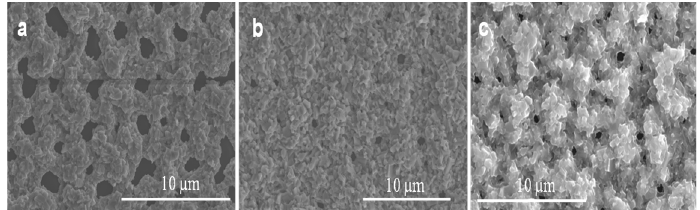
Figure 10. Growth of nanocrystalline grains of Ga 2 O 3 under 300 nm Ag presence at different oxygen concentrations. ( a ) 0.088 mL/min. ( b ) 0.16 mL/min. ( c ) 0.28 mL/min. concentrations. ( a ) 0.088 mL / min. ( b ) 0.16 mL / min. ( c ) 0.28 mL /